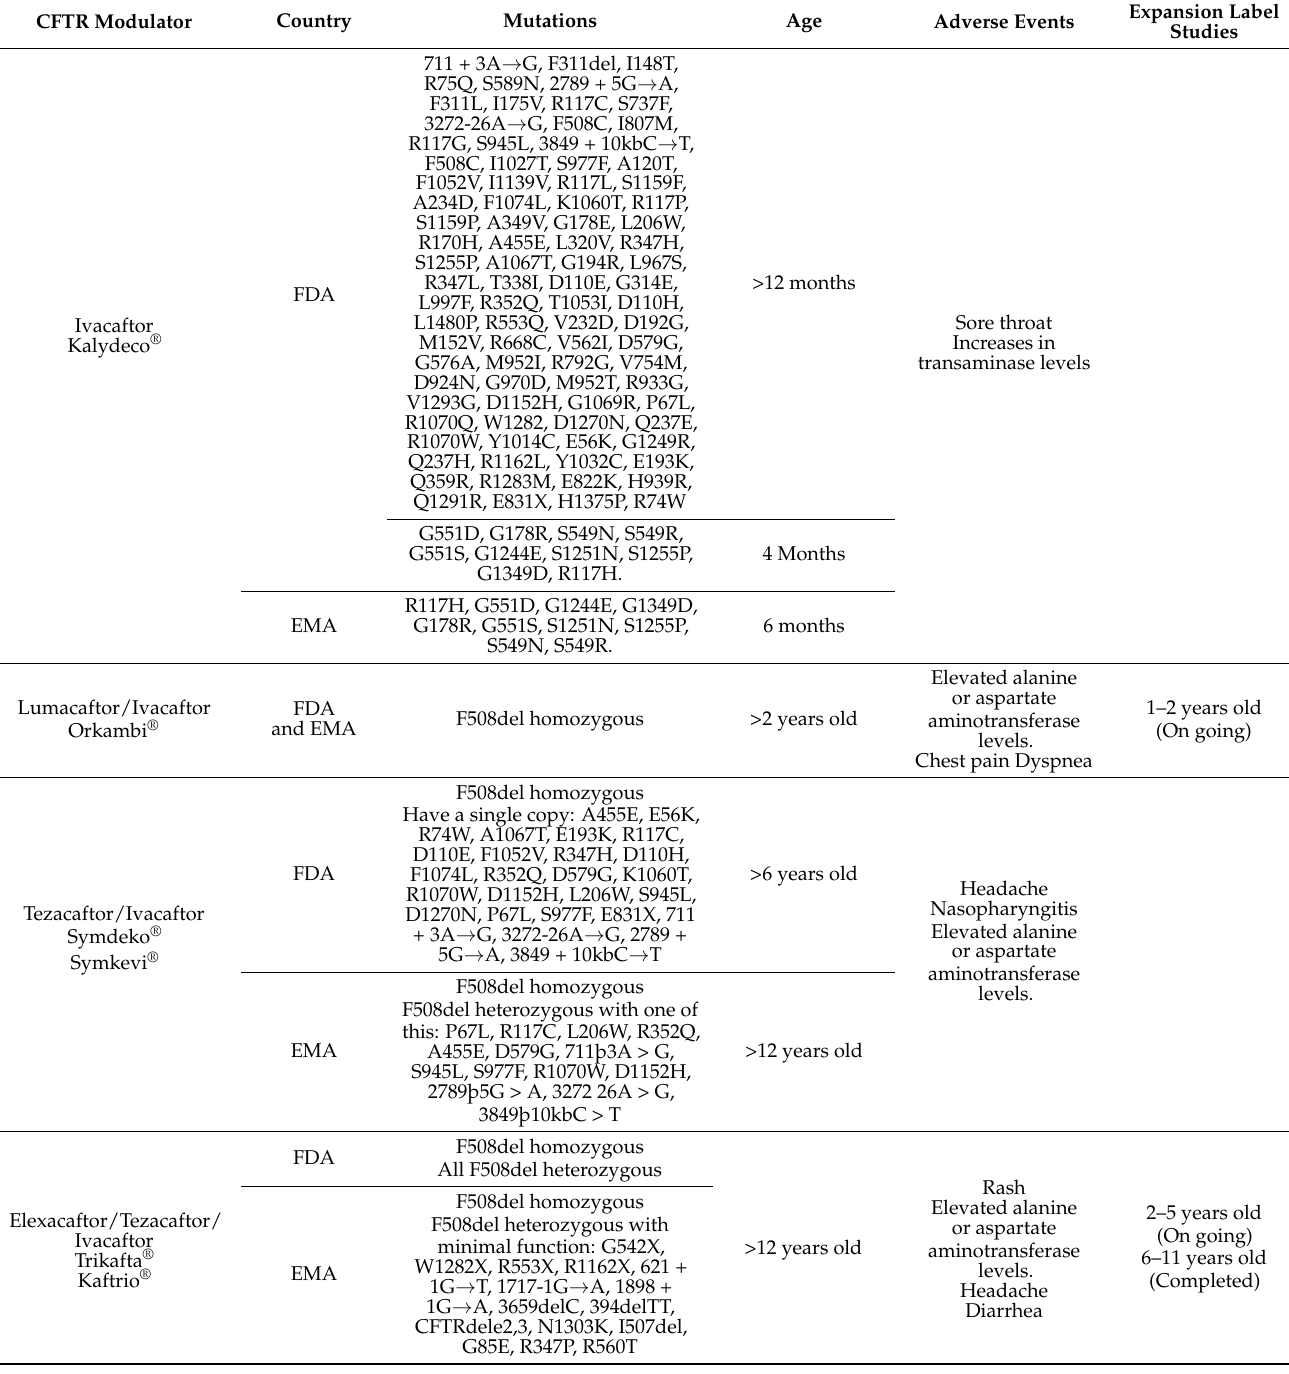
Table 6. Comparative CFTR